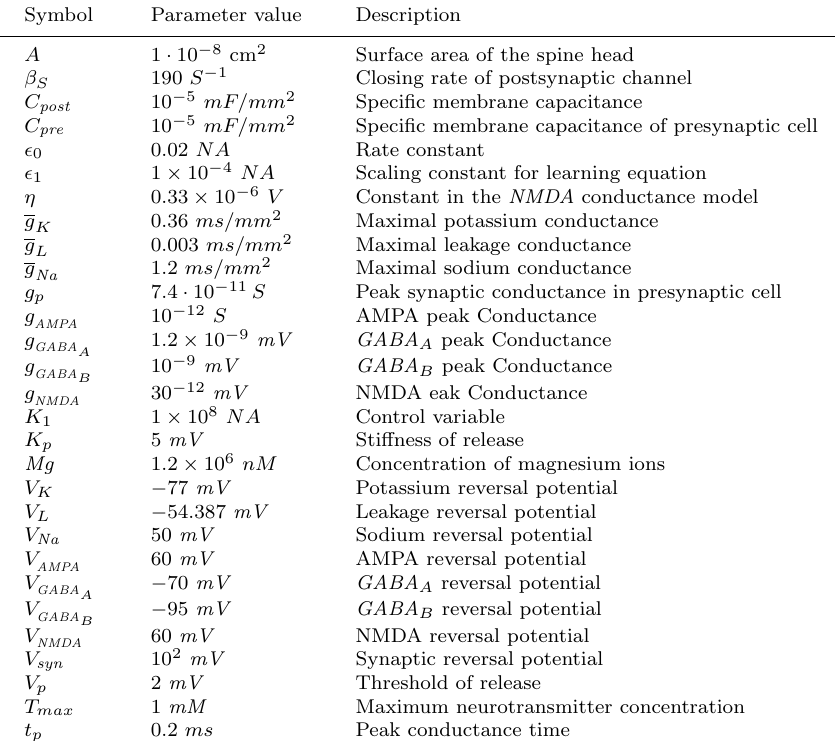
Table 1. Parameter values for the